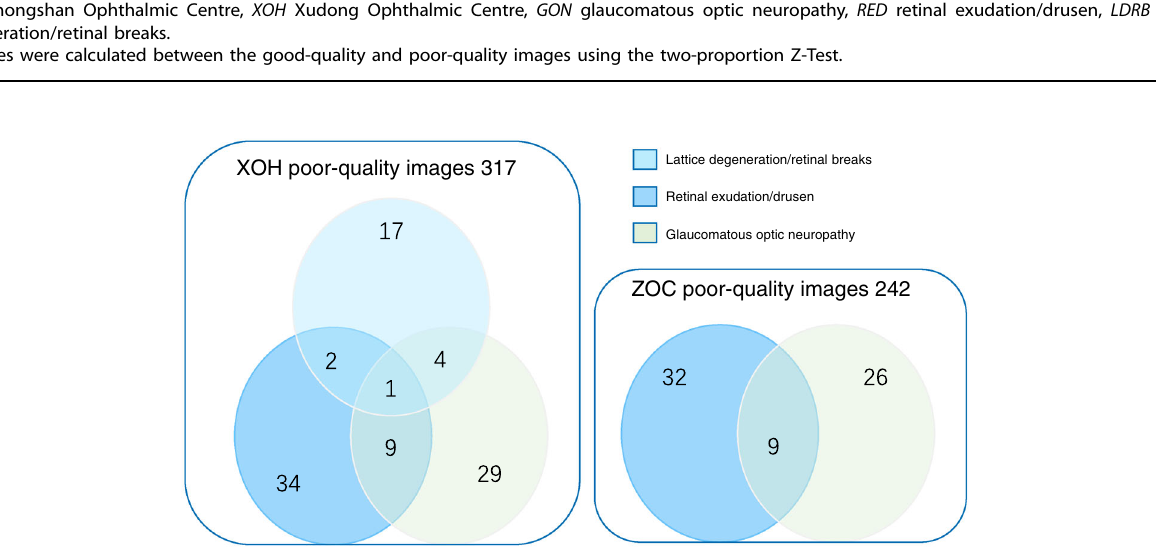
Fig. 5 Overlapping ocular fundus diseases in poor-quality images of the XOH and ZOC datasets. The numbers shown in the fi gure indicate the number of images.